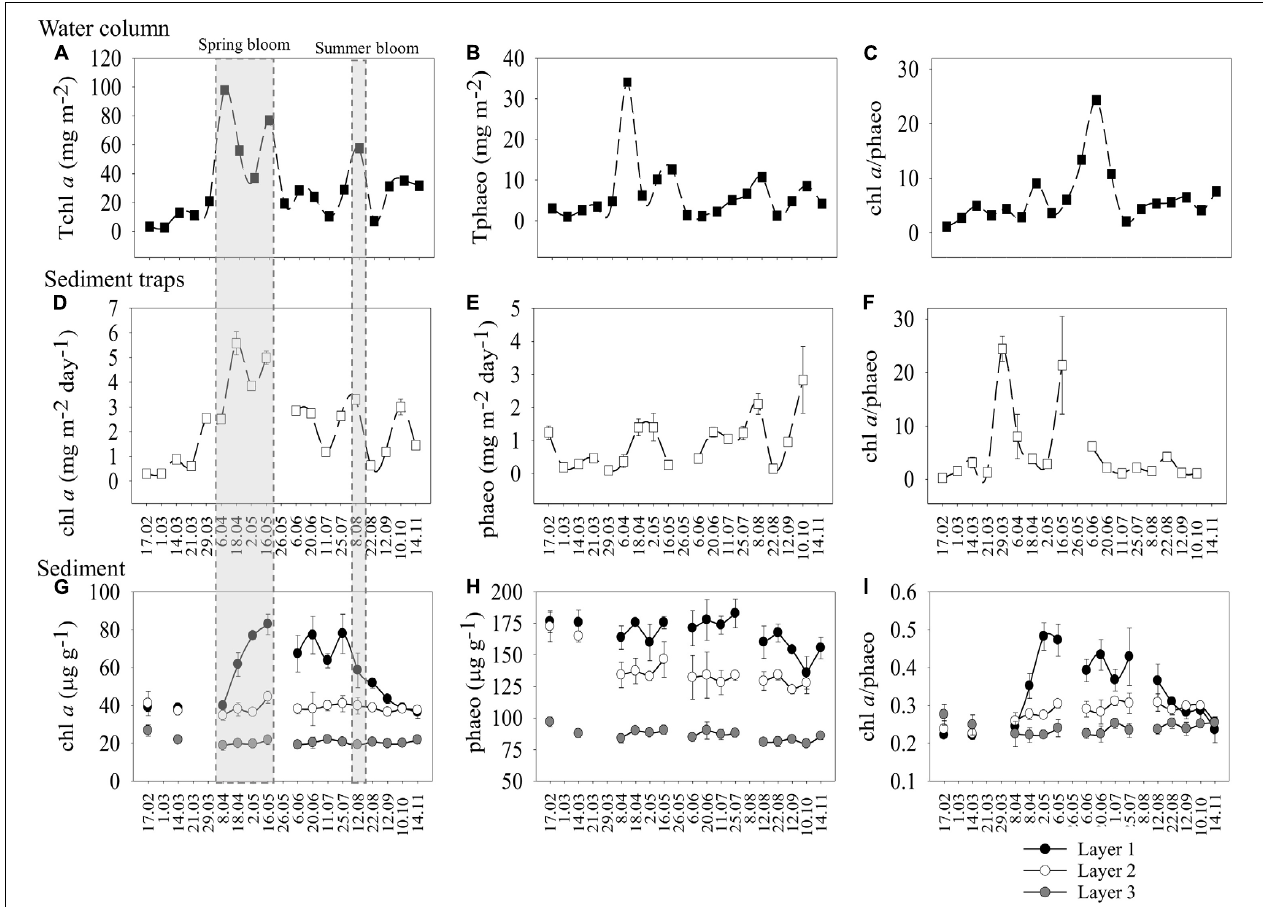
FIGURE 1 | Temporal variations (from February to November 2016) of chlorophyll a and phaeopigment concentrations and the chlorophyll a /phaeopigment ratio in the depth-integrated water column particulate organic matter (0.5–7 m) (A–C) , sediment traps (at 20 m) (D–F) and seafloor sediment (three different layers) (G–I) in Storfjärden bay ( ∼ 33 m deep). Gray shadow indicates bloom periods and a possible time lag between compartments. Mean values ± SD are shown for the traps and the sediment layers (chl a ) and depth integrated values for the water column (Tchl a